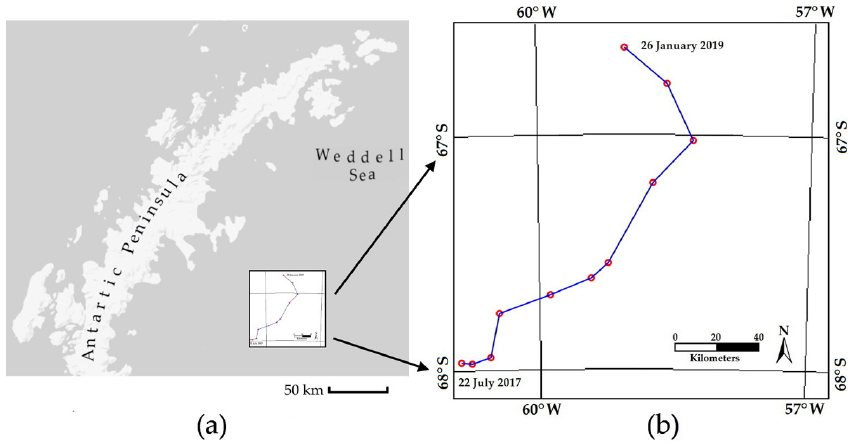
Figure 8. The derived sequence of the A-68A iceberg positions: ( a ) Overview of the derived iceberg drift, eastern Antarctic Peninsula (Google Maps©). The blue rectangle indicates the drift area; ( b ) Iceberg locations. The centroid coordinates are used to display the drift